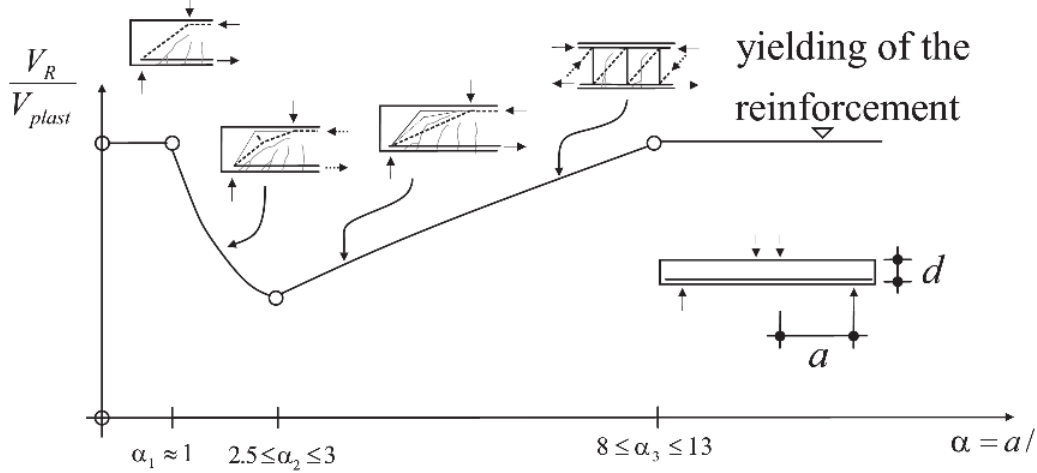
Influence of the shear span to depth ratio a/d in the shear force strength (adapted from Muttoni and Fernandez Ruiz